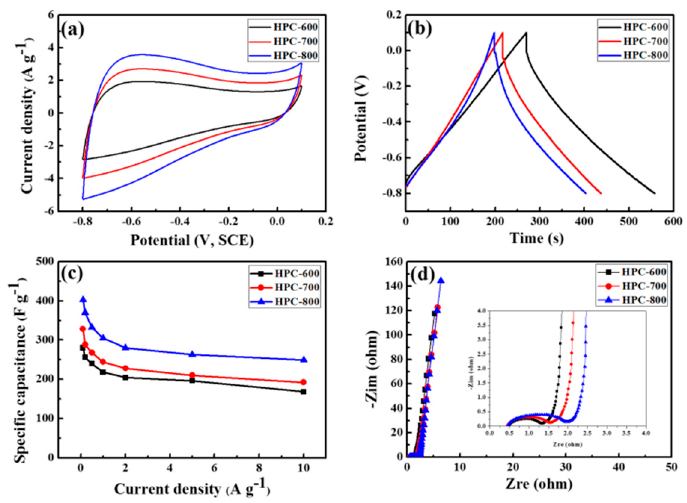
Figure 6. Electrochemical performance of all the HPC electrodes measured in a three-electrode system: ( a ) Cyclic voltammetry (CV) curves at a scan rate of 10 mV · s − 1 ; ( b ) Galvanostatic charge/discharge (GCD) curves at a current density of 1 A · g − 1 ; ( c ) specific capacitances at different current densities; and ( d ) Nyquist plots and inset magnified image.